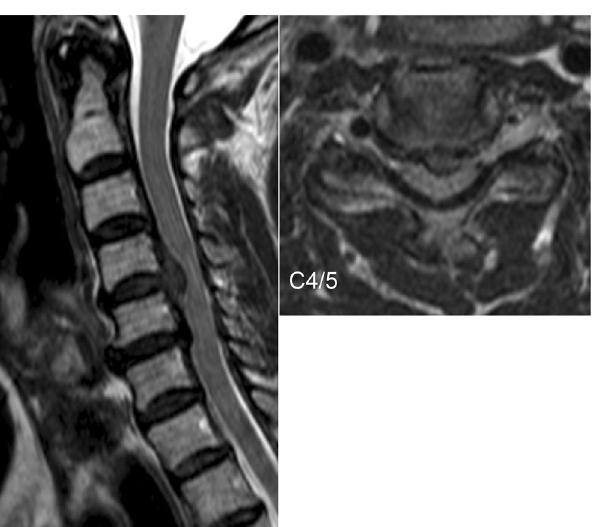
Figure 3. Preoperative MR image of a patient with cervical spondylotic myelopathy showing spinal stenosis. The patient was a 67-year-old male with C4/5 disc herniation and a small indentation of the C5/6 disc. The patient exhibited clumsiness of bilateral hands and gait